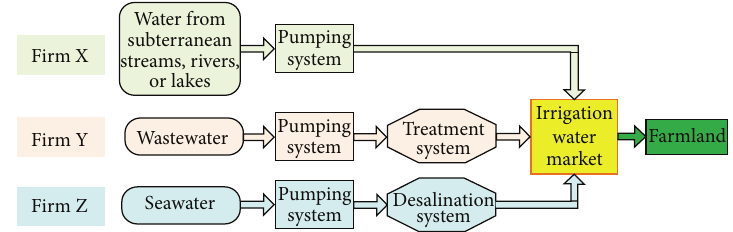
Figure 1: Schematic diagram of water supply in the coastal irrigation